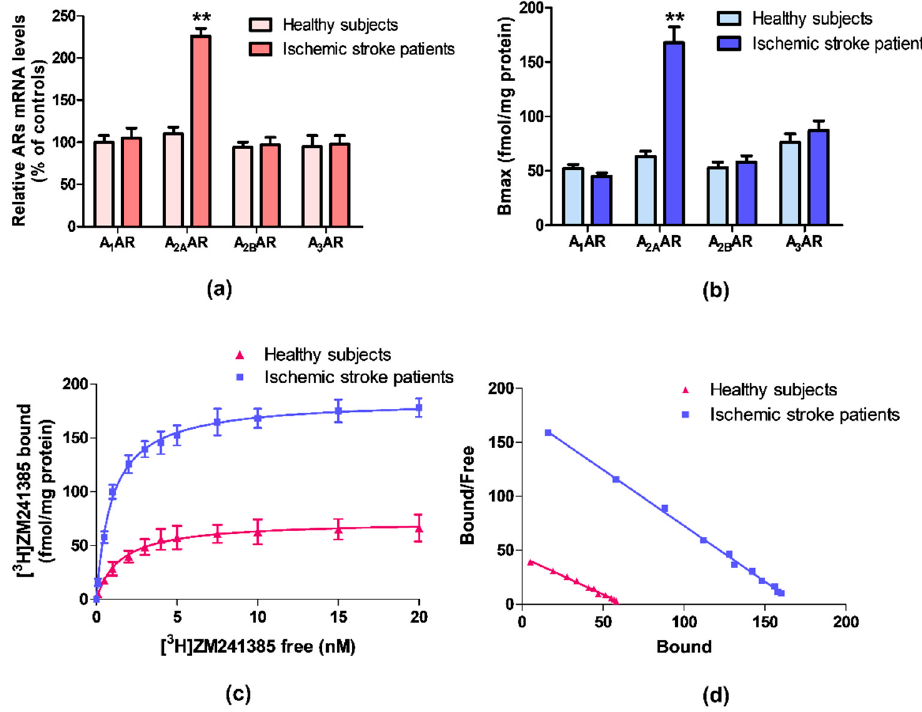
Figure 1. ( a ) Relative adenosine receptors (ARs) mRNA levels determined by reverse transcription (RT)-polymerase chain reaction (PCR) in human lymphocytes from ischemic stroke patients (n = 50) and control subjects (n = 50). ( b ) Density of A 1 , A 2A , A 2B , and A 3 ARs, expressed as Bmax, in lymphocytes derived from ischemic stroke patients (n = 50) in comparison to control subjects (n = 50). ( c ) Saturation curve and ( d ) Scatchard plot of [ 3 H]-ZM 241385 to A 2A ARs in lymphocyte membranes derived from ischemic stroke patients (n = 50) and control subjects (n = 50). Data are expressed as the mean ± SEM. ** p < 0.01 vs control group.